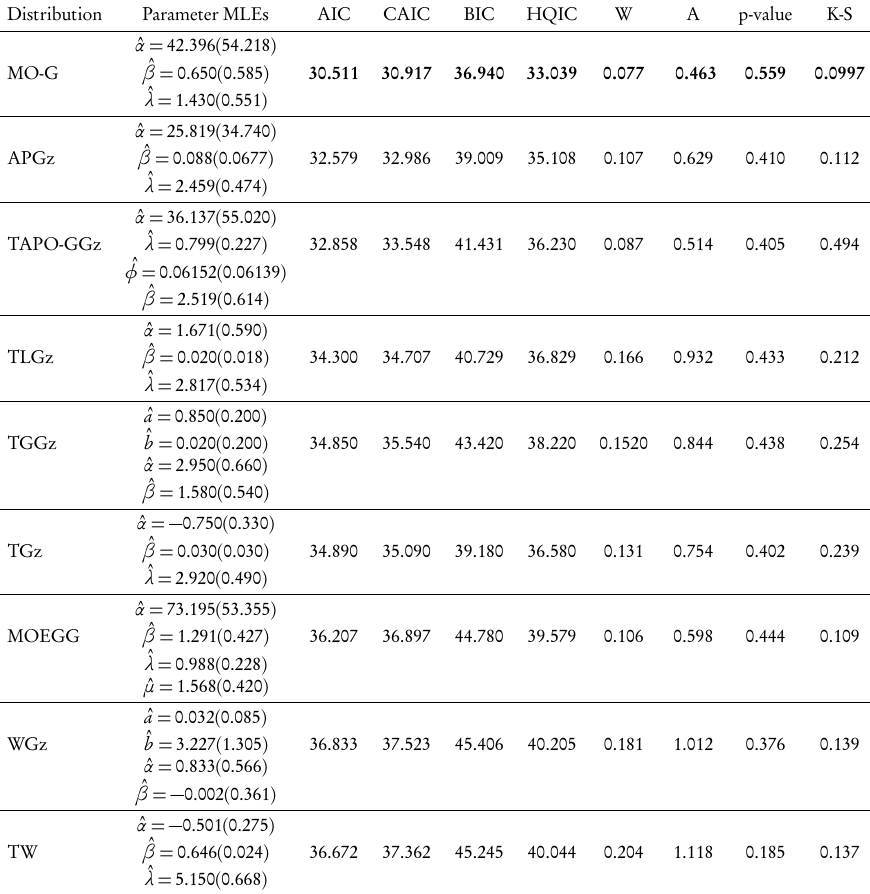
The statistics rating for MO-G distribution with glass fibres dataset with standard errors in